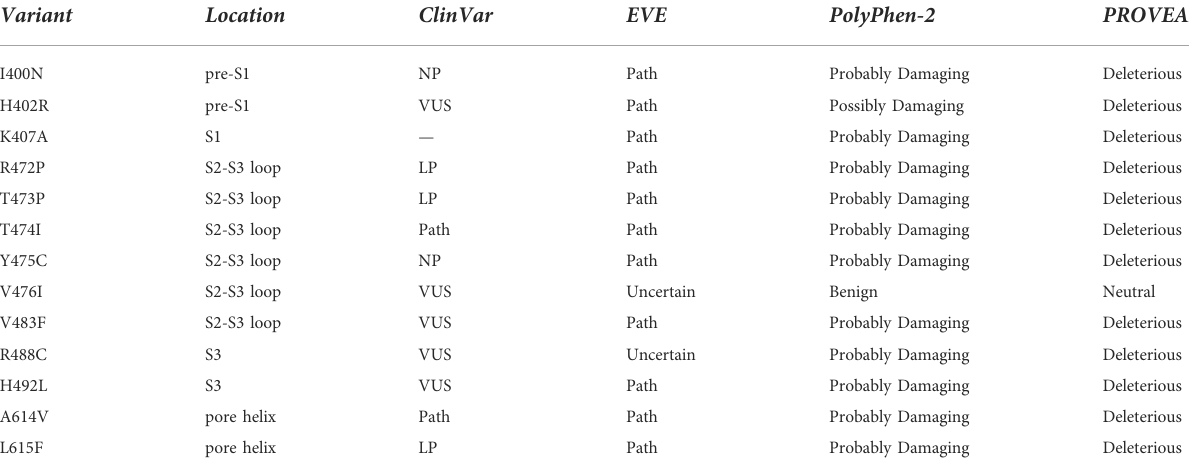
TABLE 3 hERG VSD variants selected for traf fi cking phenotyping based on EC analysis.